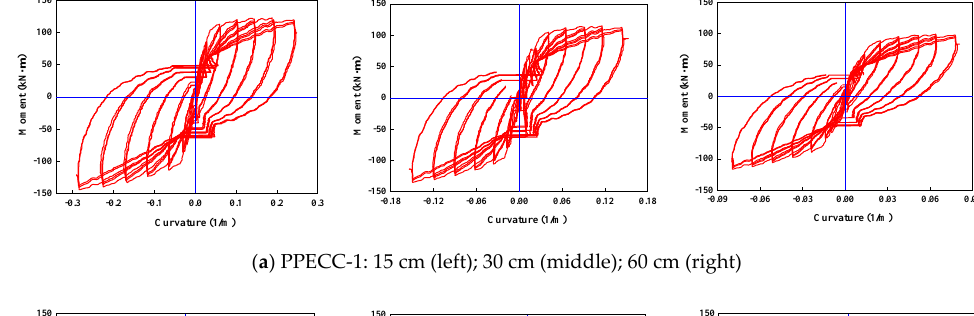
( a ) PPECC-1: 15 cm (left); 30 cm (middle); 60 cm (right)